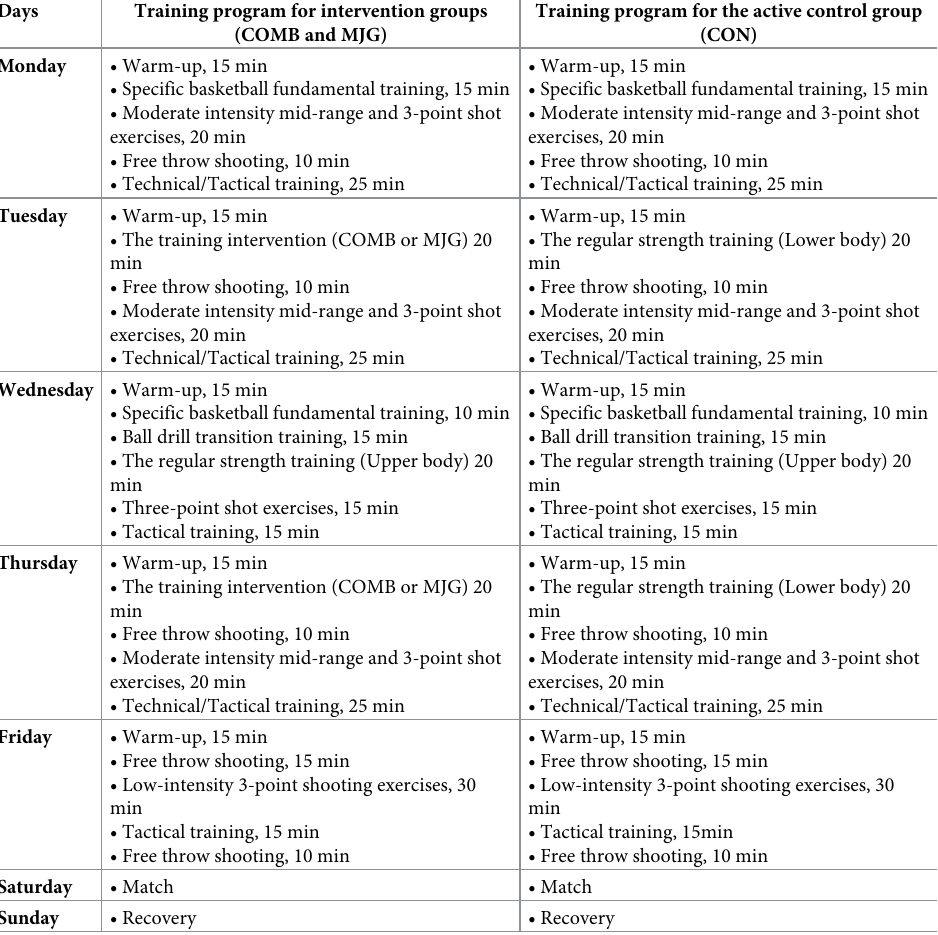
Table 1. Weekly training program during the experimental period for intervention and control